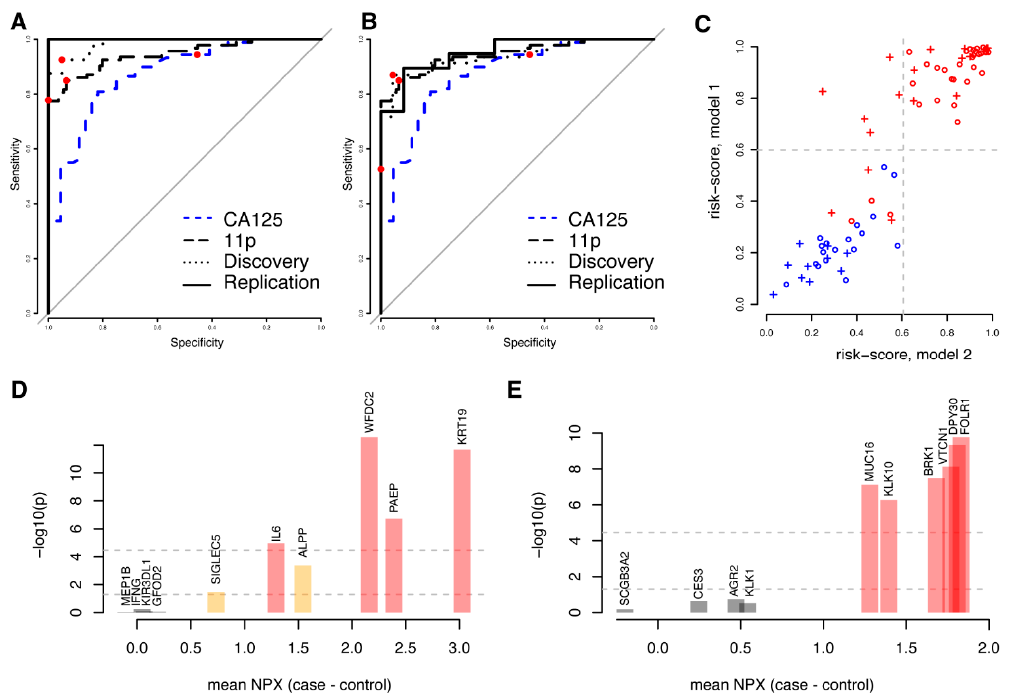
Figure 3. Comparison of two disjunct multivariate models based on all proteins. ( A ) ROC curve for the first model (‘m1 (cid:48) , including ALPP, GFOD2, IFNG, IL6, KIR3DL1, KRT19, MEP1B, PAEP, SIGLEC5, and WFDC2) in the validation (solid line) and training (dashed line) cohorts for separating benign controls from ovarian cancer stages I–IV. The combined performance of clinically measured MUCIN-16 (CA125) in the same cohorts is shown as a dashed blue line and the performance of the previously developed eleven-biomarker panel [15] is shown as a long-dashed black line. In each ROC curve, the point estimate of sensitivity and specificity at a cut-off (‘best-point’ for multivariate models, 35 U/mL for clinical MUCIN-16) is indicated by a red dot. ( B ) As ( A ), but for the second model (‘m2 (cid:48) , including AGR2, BRK1, CES3, DPY30, FOLR1, KLK1, KLK10, MUCIN-16, SCGB3A2, and VTCN1). ( C ) Comparison of risk scores for each individual in the training cohort (circles) and validation cohort (crosses) for the two models. Benign samples are illustrated in blue and malignant samples are illustrated in red. The dashed light-grey lines correspond to the cut-off for malignancy in the two models: 0.599 for the first model ( y -axis) and 0.606 for the second ( x -axis). ( D ) Univariate results for the proteins in the first model. The x -axis indicates mean differences between cases and controls in the discovery cohort and the y -axis represents the statistical significance of this difference (in − log10). The two horizontal lines indicate nominal significance levels and those adjusted for multiple hypothesis testing and is also indicated by the colours of the bars. ( E ) As ( D ), but for the second